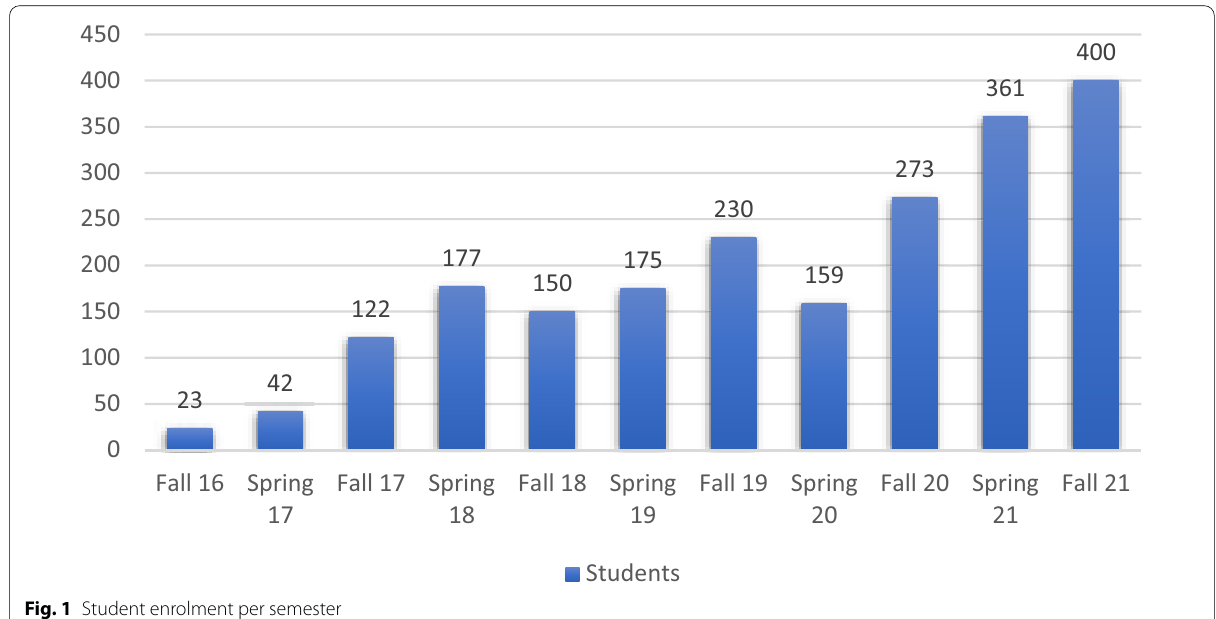
Fig. 1 Student enrolment per